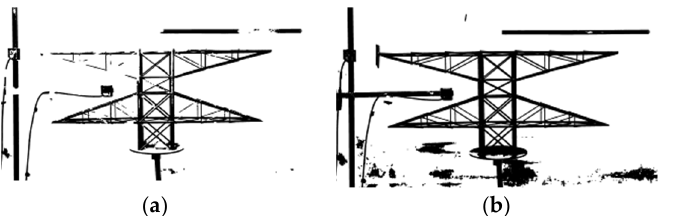
Figure 9. Comparation of binary images before and after histogram equalization method. ( a ) binary image before the histogram equalization method. ( b ) binary image after histogram equalization method.